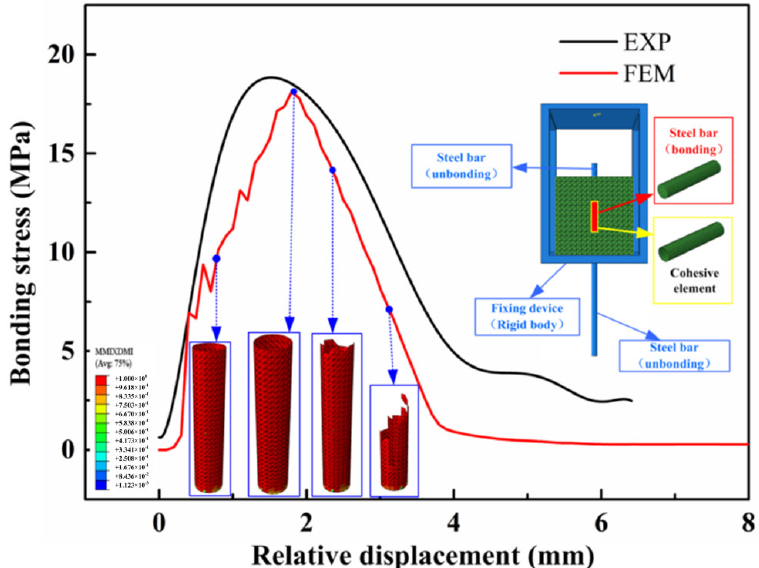
Figure 6. Comparison between numerical and experimental results.